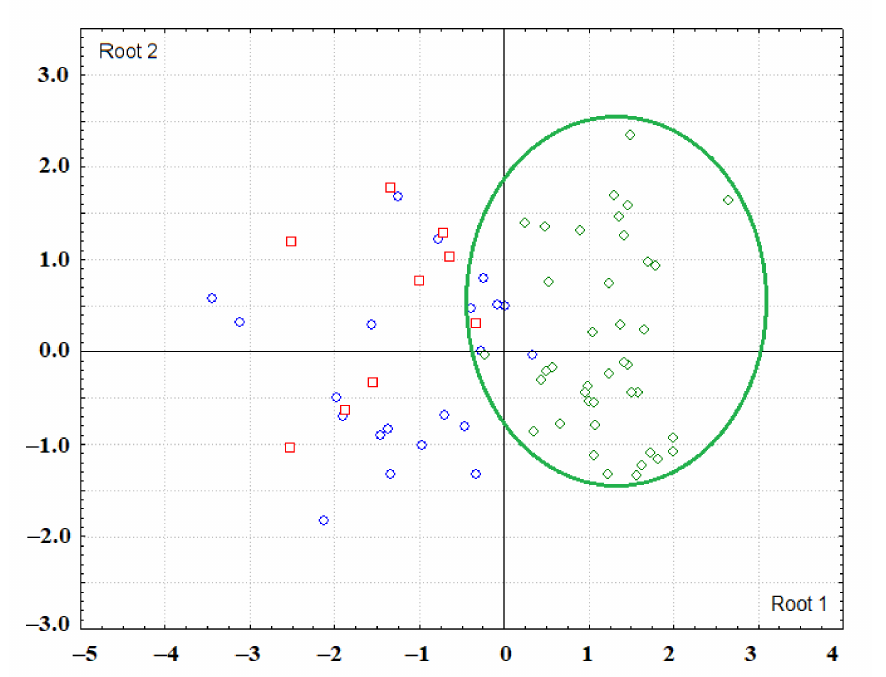
Figure 5. Scatter plot of canonical values for breast cancer patients by stage (blue circles—T 1-2 N 0-1 M 0 , red squares—T 3-4 N 0-2 M 0 ) and fibroadenomas (green diamonds). The ellipses mark the groups, the differences of which with others are statistically significant.